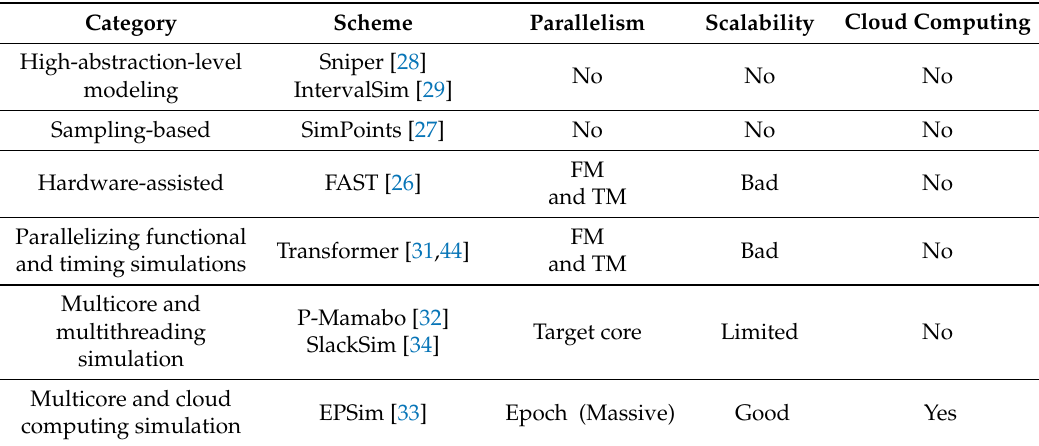
Table 2. Comparison of the related schemes with our EPSim. FM and TM denote functional and timing models,